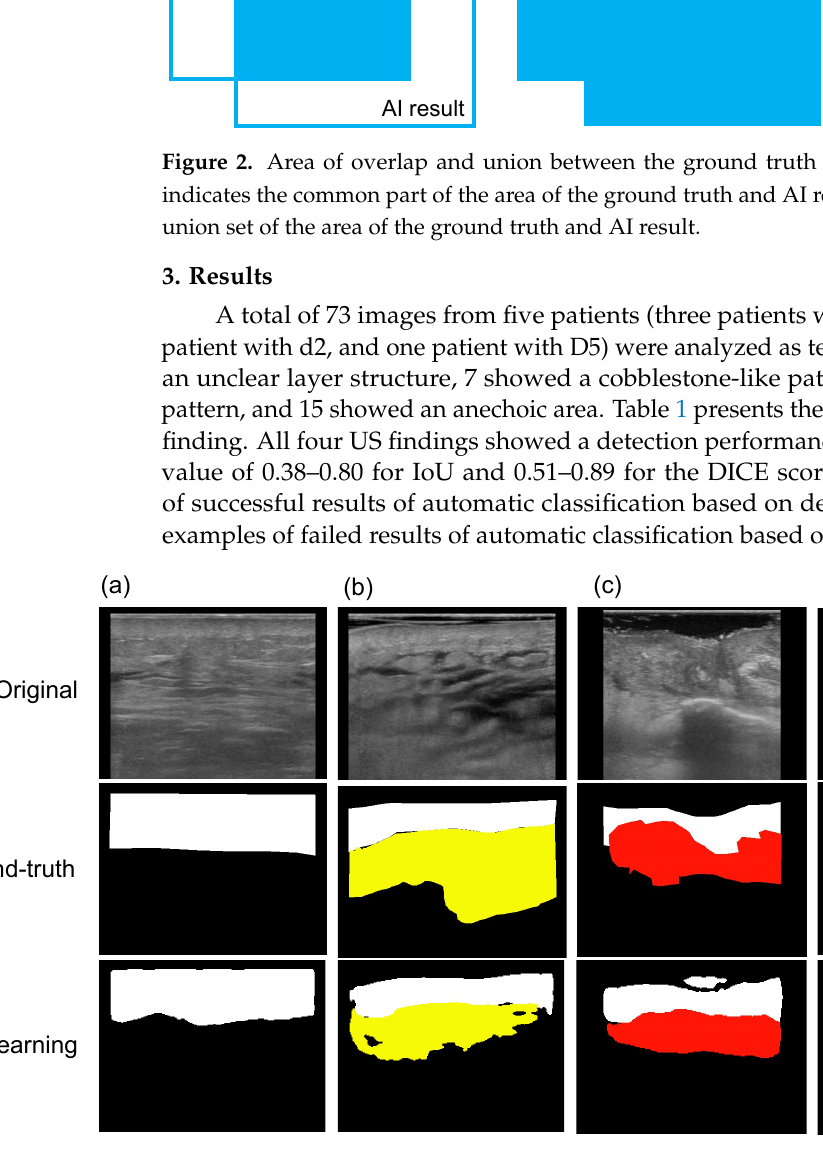
Figure 3. Examples of successful results of automatic classification based on deep learning. ( a ) Unclear layer structure. ( b ) Cobblestone-like pattern. ( c ) Cloud-like pattern. ( d ) Anechoic pattern. The “ground-truth” images show the regions that were manually annotated by the expert. The “deep-learning” images show the regions extracted as a result of automatic classification. White indicates an unclear layer structure, yellow indicates a cobblestone-like pattern image, red indicates a cloud-like pattern image, and purple indicates an anechoic pattern image. The values of the intersection over union (IoU) are, from left to right, 0.88, 0.57, 0.68, and